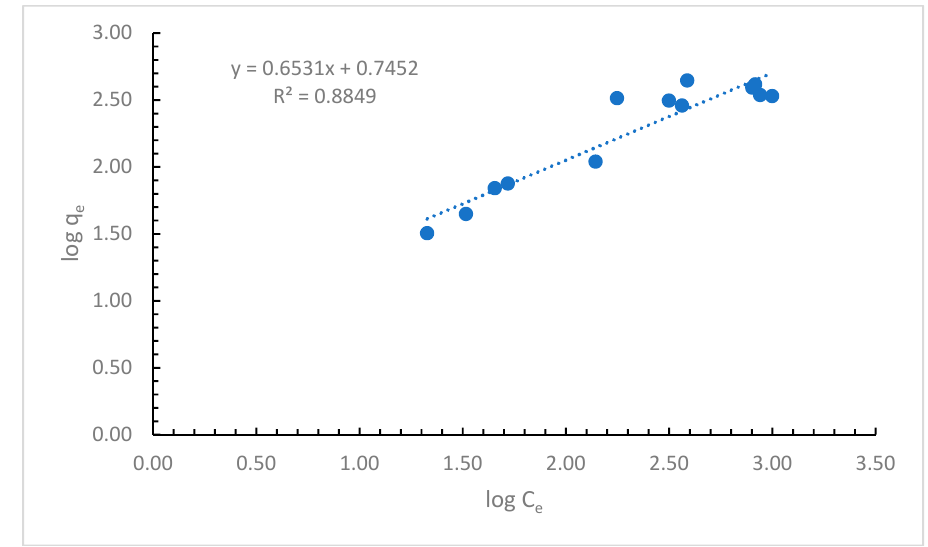
Figure 3. Freundlich adsorption isotherm.